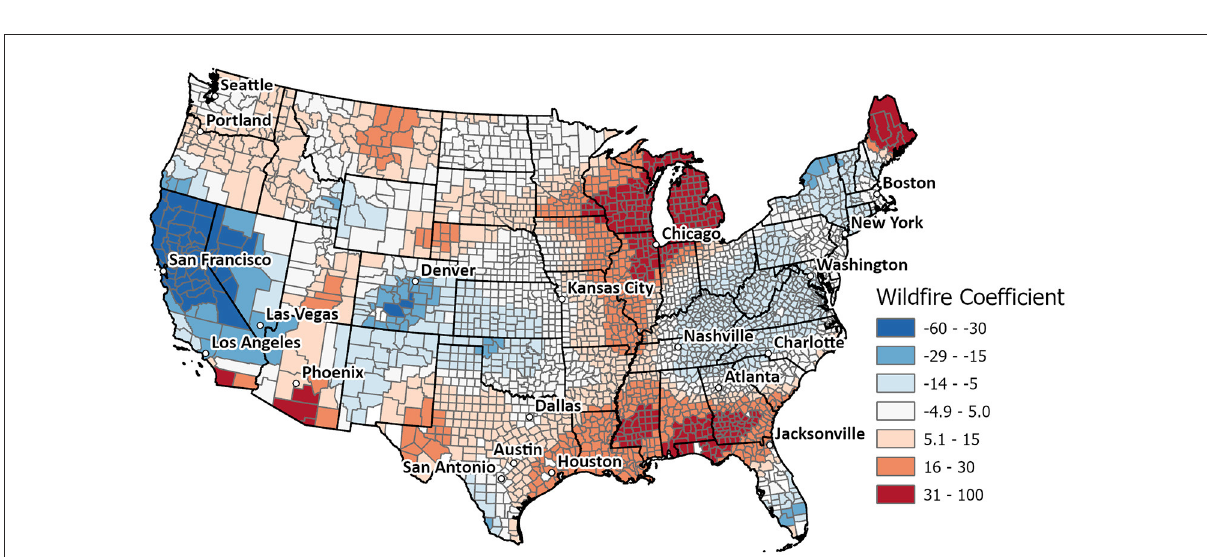
FIGURE5 Local model coefficients for wildfire in the GWR. Values ranged from people have been moving away from counties with a higher risk of wildfires or toward counties with lower risk. Positive values (in shades of red) indicate regions where people are moving toward counties with higher risk or away from counties with lower